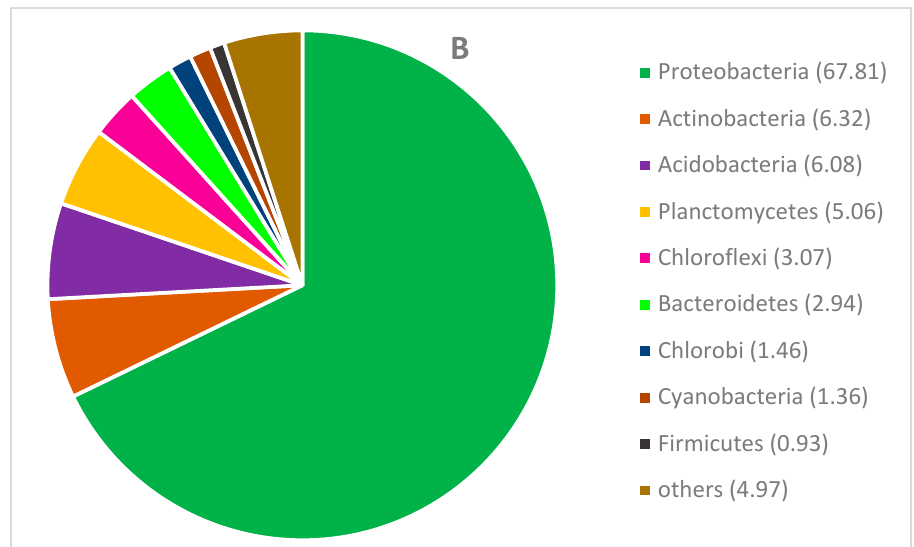
Figure 6. Bacterial community structure shown as the percentage share of different phyla in the two types of PUR foam samples (figures ( A ) and ( B ) refer to the PUR foam samples ( A ) and ( B ), respectively).